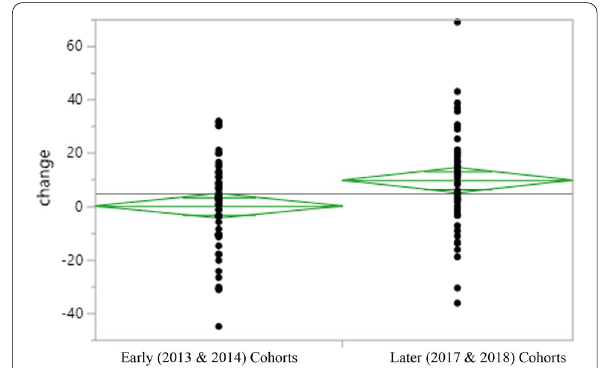
Fig. 1 Change in DO scores between pre- and post for early vs. later groups Table 5 ANOVA for difference between the early (2013 and 2014) and later (2017 and 2018) groups Source DF Sum of